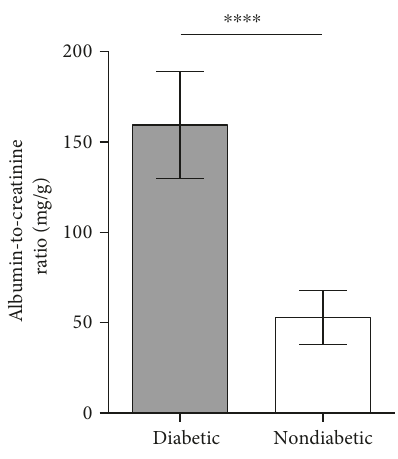
Figure 3: Albumin-to-creatinine ratio (AcR) in diabetic and nondiabetic mice. AcR measurements of diabetic ( n = 12 ) and nondiabetic ( n = 12 ) mice at the end of the study. Student ’ s t -test was used to test the di ff erence between groups. ∗∗∗∗ p < 0 0001 . Data is given in mean with standard deviations